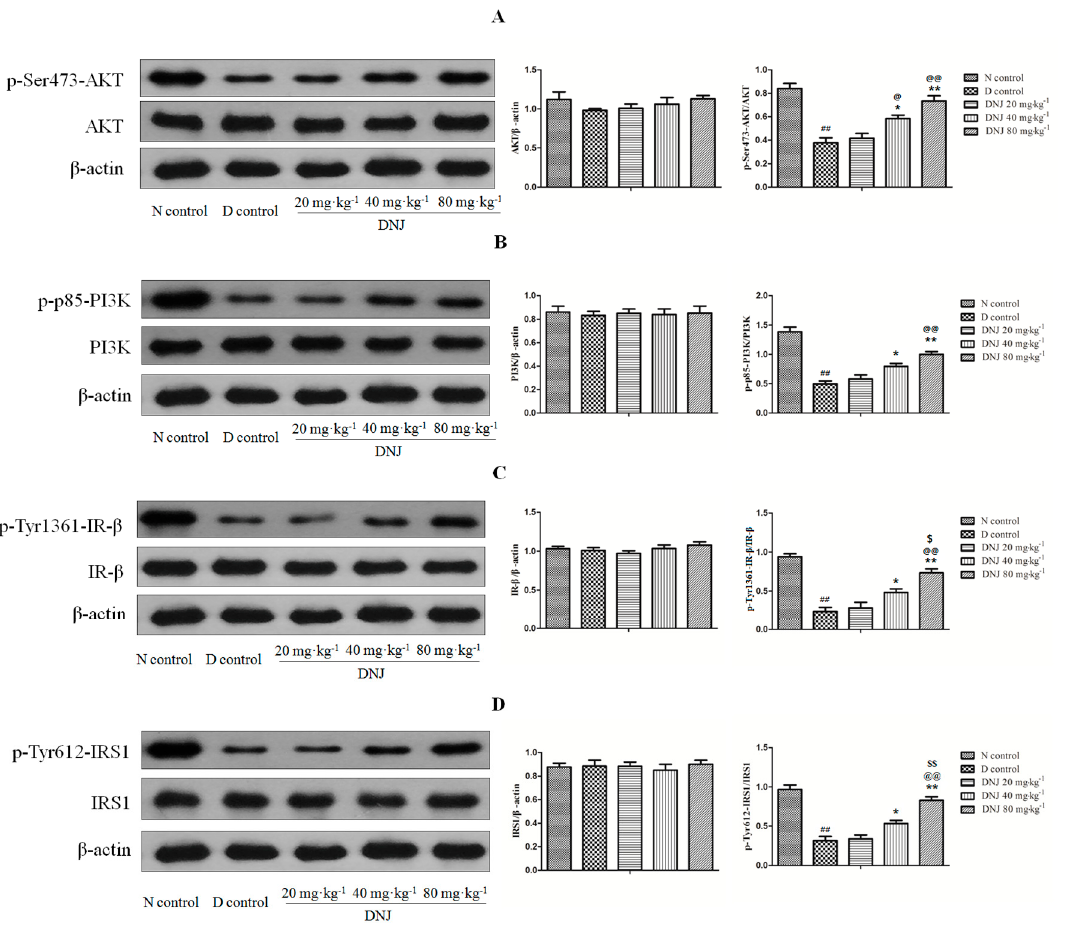
Figure 7. Effects of DNJ on expression of AKT, PI3K, IR- β , and IRS1 and their phosphorylation in db/db mice. Western blot analysis for p-AKT and AKT ( A ); p-PI3K and PI3K ( B ); p-IR- β and IR- β ( C ); and p-IRS1 and IRS1 ( D ) in skeletal muscle of db/db mice. These data were representative of three independent experiments. Results were normalized by β -actin, ## p < 0.01 vs. N control; * p < 0.05, ** p < 0.01 vs. D control; @ p < 0 .05, @@ p < 0.01 vs. DNJ 20 mg·kg − 1 ·day − 1 ; $ p < 0.05, $$ p < 0.01 vs. DNJ 40 mg·kg − 1 ·day − 1 ( n = 3).